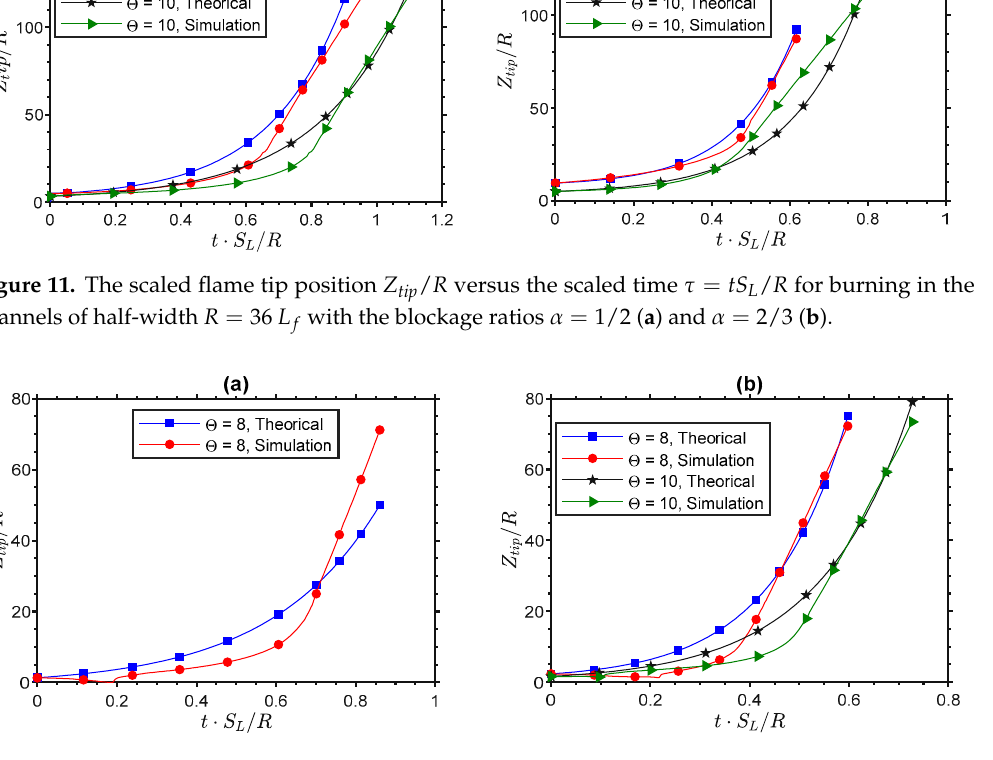
Figure 12. The scaled flame tip position Z tip / R versus the scaled time τ = tS L / R for burning in the channels of half-width R = 48 L f with the blockage ratios α = 1/2 ( a ) and α = 2/3 ( b ).